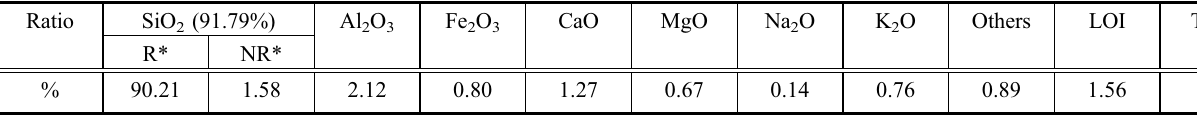
Table 3 Chemical composition of